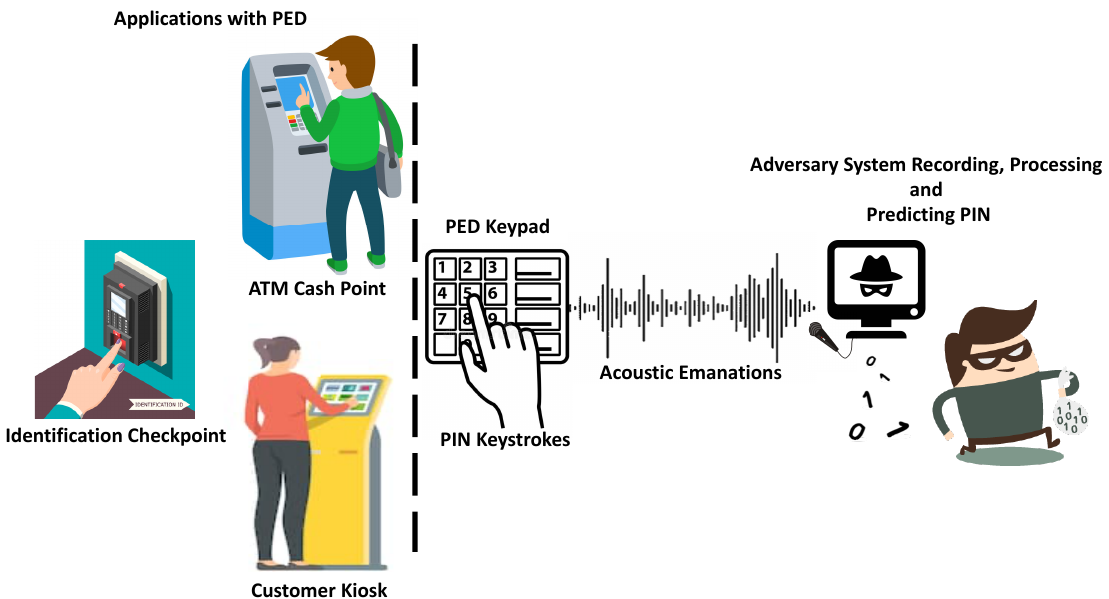
Figure 1. PIN Attack: Acoustic emanations generated from PED keystrokes are recorded and processed to predict a PIN key by an